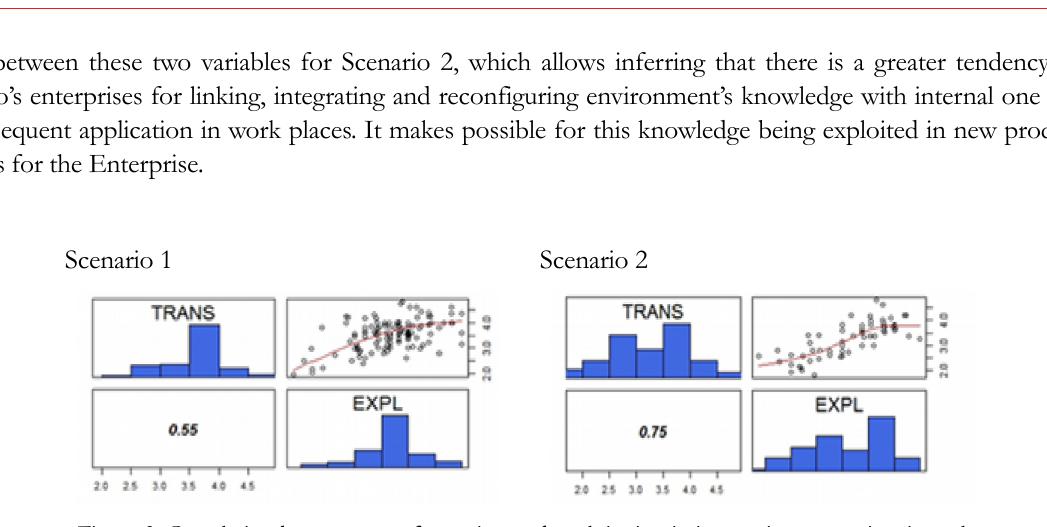
Figure 3. Correlation between transformation and exploitation in innovative enterprises in each of the two